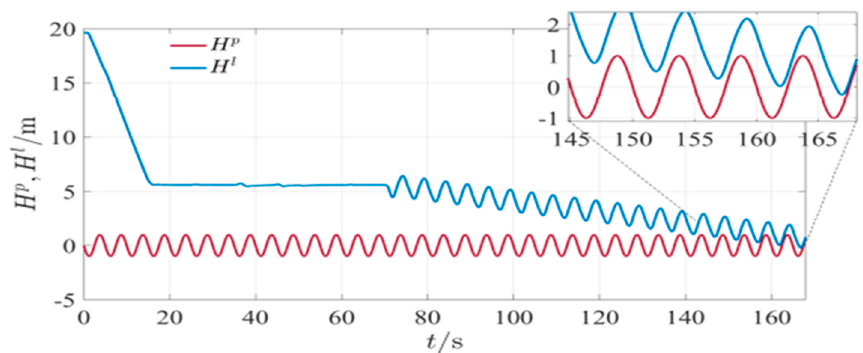
Figure 41. The evolution of H p and H l vs. time when A